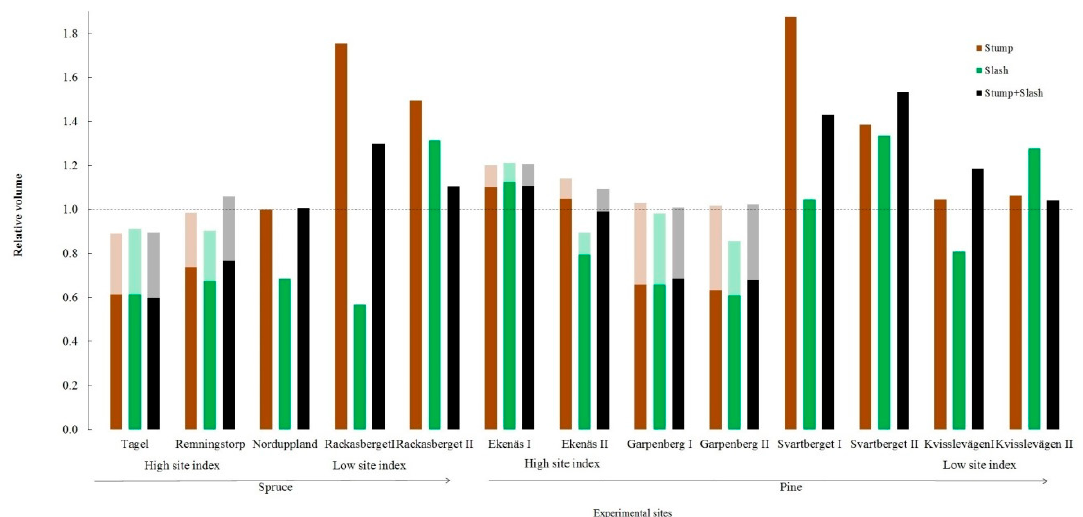
Figure 1. Block level data from eight experimental sites showing relative stand volume production 334 during 31–34 years for stands planted after additional harvest of stumps, slash, both stumps and slash, 335 relative to the control treatment where only the stem wood was harvested leaving stumps and slash 336 behind (horizontal dashed line) that is set to 1. Standing volume at the last revision is colored darker 337 and stem volume removed in thinnings lighter. 338